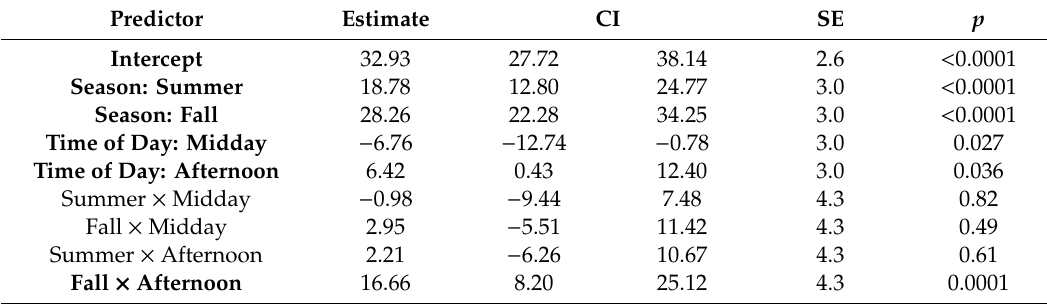
Table 2. Summary of the generalized linear mixed model predicting shade availability by season, time of day, and their interaction (denoted with × ). Significant model predictors are indicated in bold. The reference category for season is spring, the reference category for time of day is